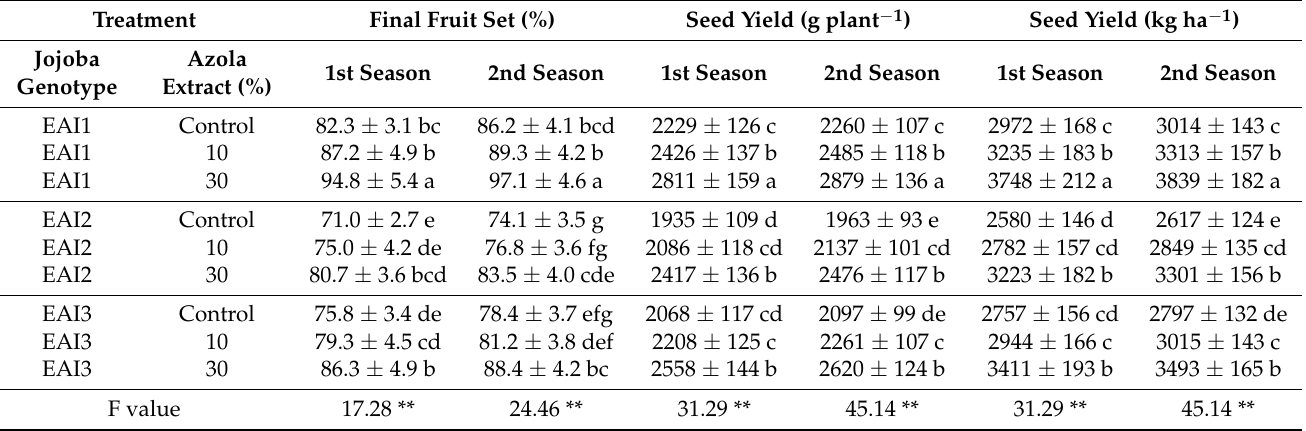
Table 3. In both seasons of the study, the mean values of final fruit set (%), seed yield (g plant − 1 ), and seed yield (kg ha − 1 ) of jojoba shrubs as influenced by combined treatments of plant genotypes and foliar application of Azolla filiculoides Lam. plant